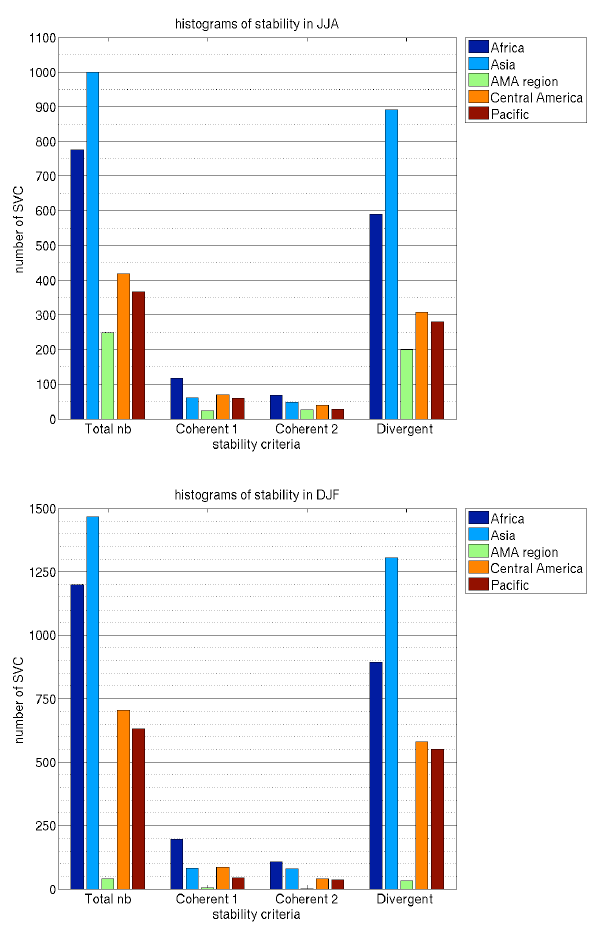
Fig. 6. Histograms of SVC temperature history coherence in JJA (top) and DJF (bottom) by